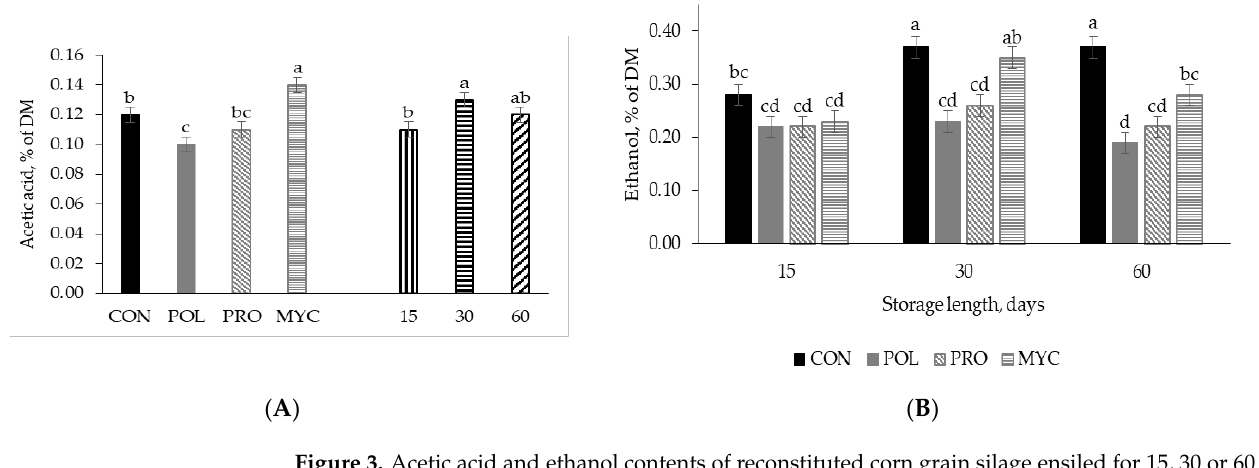
Figure 3. Acetic acid and ethanol contents of reconstituted corn grain silage ensiled for 15, 30 or 60 d, without additives treatment (CON), or treated with polysorbate 80 (POL), propionic acid (PRO) or polysorbate 80 and propionic acid (MYC). Statistical effects observed for ( A ) Acetic acid–Additive, p < 0.01, SEM = 0.004; Storage, p < 0.01, SEM = 0.003; A × S, p = 1.00; ( B ) Ethanol–Additive, p < 0.01; Storage, p < 0.01; A × S, p < 0.01, SEM = 0.02. Different letters differ by Tukey’s test ( p ≤ 0.05). As expected, the propionic acid concentration was higher ( p < 0.05) in silages treated with additives that contained propionic acid (PRO and MYC) than for those treated with CON and POL, at all lengths of storage analyzed (Figure 4A). A treatment vs. storage length interaction ( p < 0.01) was observed for the butyric acid content. All silages stored for 15 d had a lower and similar butyric acid concentration, but at d-30 and d-60 of storage, the control silages had a higher butyric acid concentration than treated silages (Figure 4B).